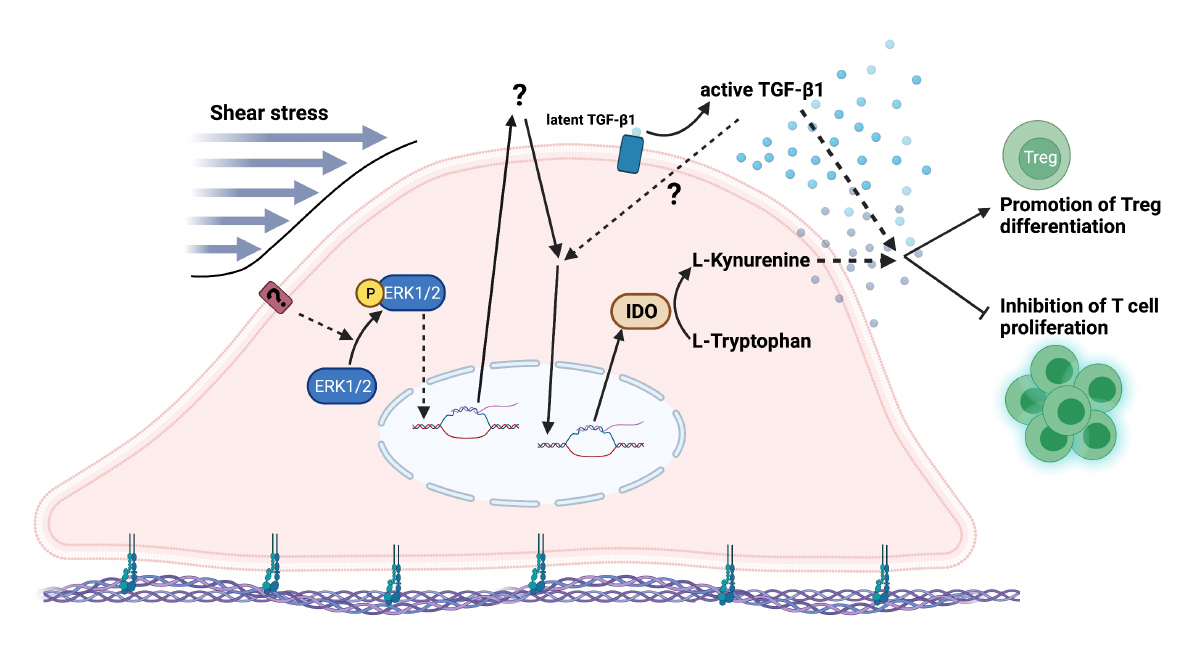
Figure 5. Schematic diagram of shear stress activates an immunosuppressive ability of hPDLSCs via ERK-induced IDO and total and active TGF- β 1. Shear stress enhances IDO-dependent kynure- nine in hPDLSCs via ERK1/2 activation and increases total and active TGF- β 1 in the extracellular matrix or conditioned medium. Increased kynurenine and TGF- β 1 secretion inhibit the CD4 + T cell proliferation and promote Treg cell differentiation. Created with